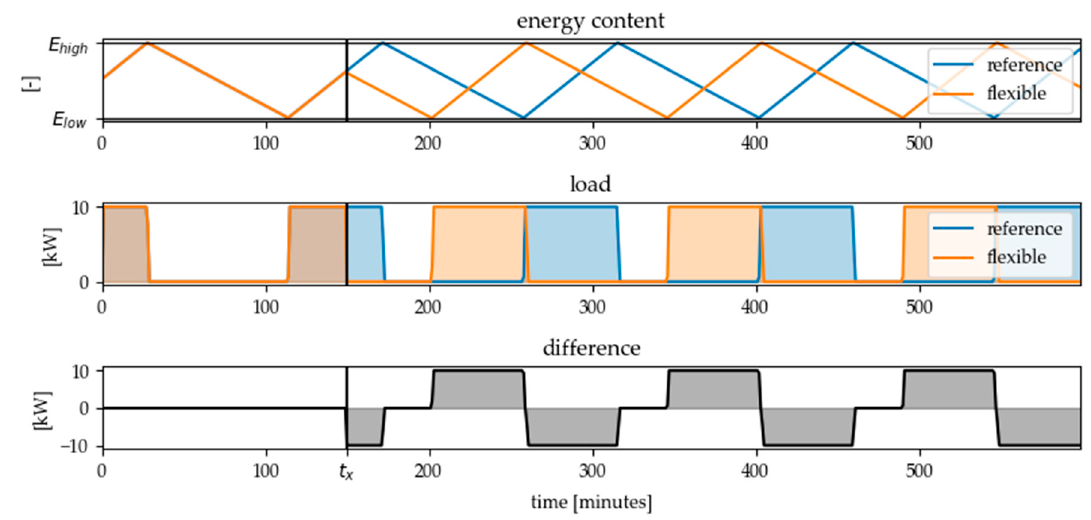
Figure 6. Resulting flexible load profile for a flexibility call of type DLC (Direct Load Control) at time step t x = 150 and a desired load reduction ( d load = − 1 ) in comparison to the reference load profile without flexibility call.